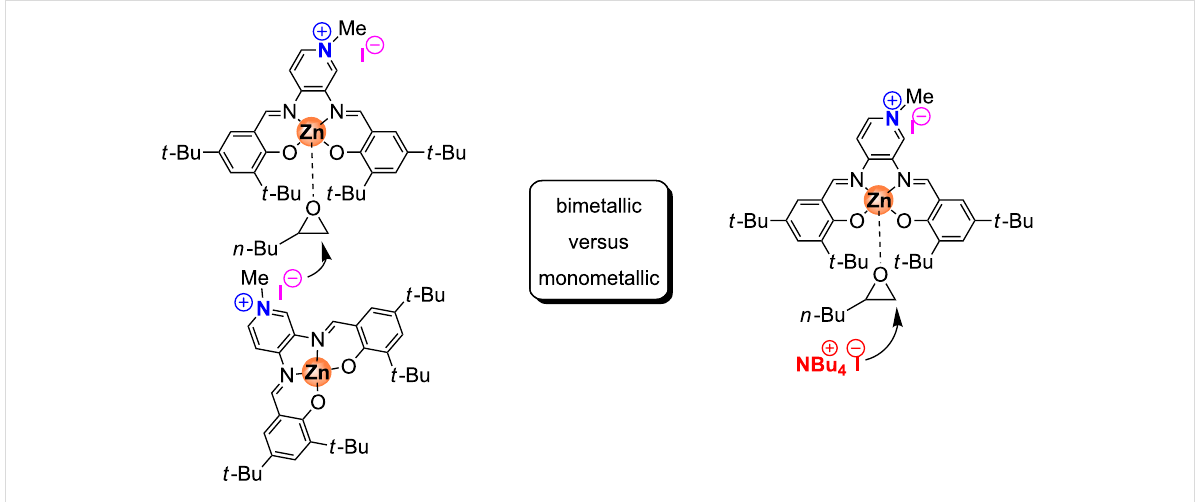
Scheme 4: On the left a dimetallic mechanism proposed for bifunctional catalyst 2 and on the right a monometallic mechanism proposed for binary catalyst 2 /NBu 4 I are shown.